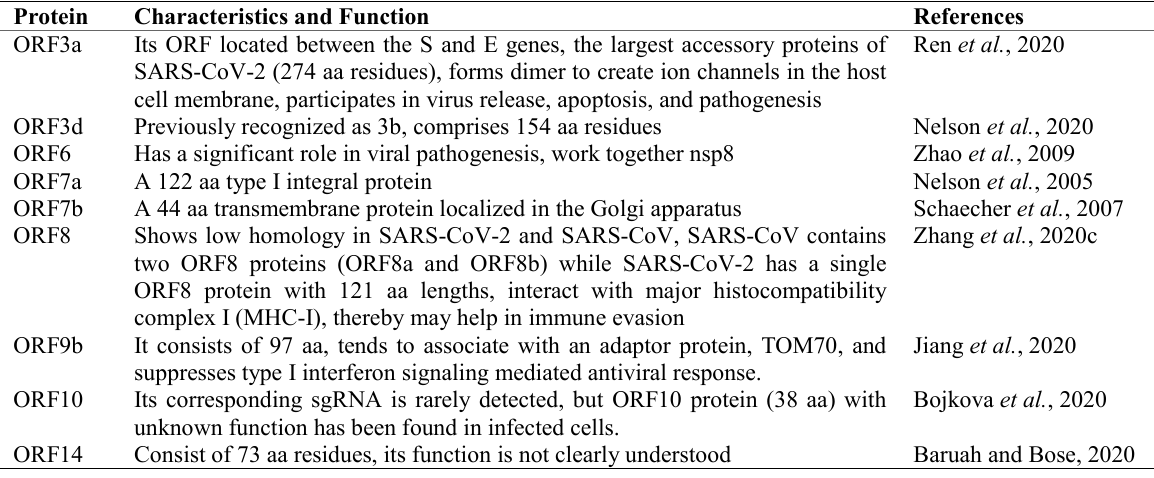
Table 1. Functions of coronavirus accessory proteins.